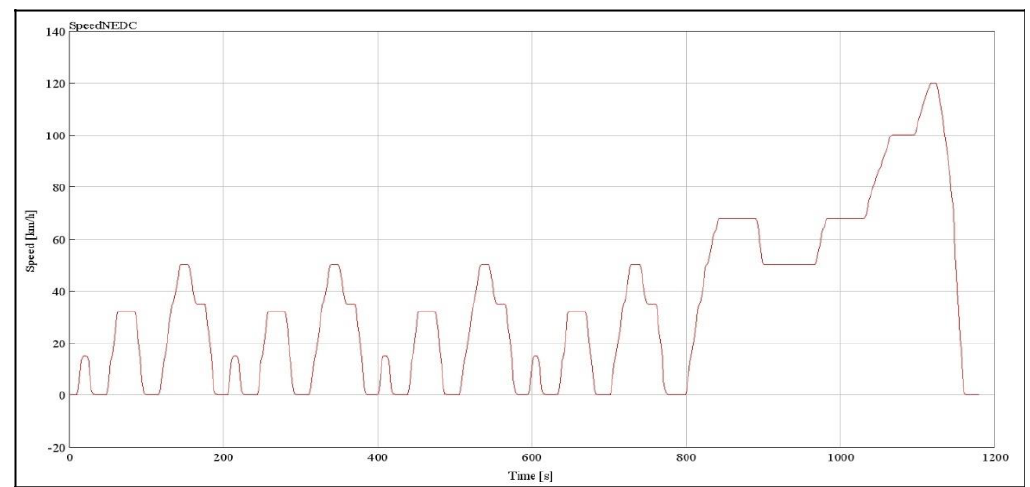
Figure 28. Driving cycle (New European Driving Cycle (NEDC)).